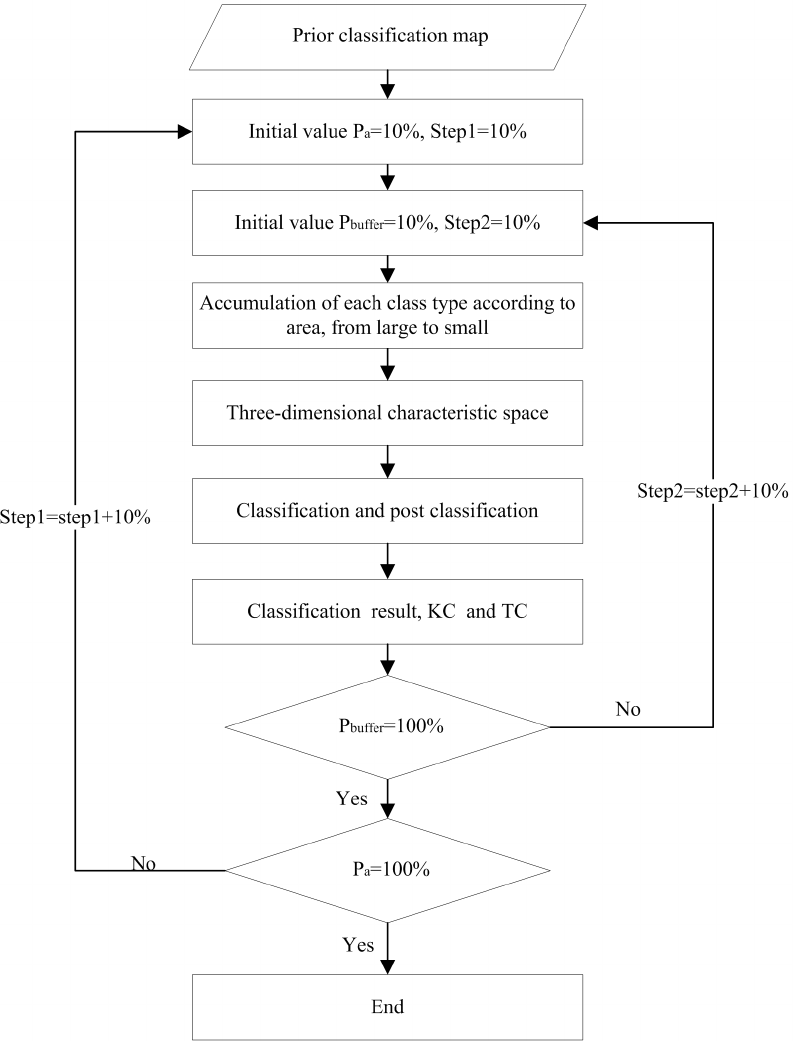
Figure 2. Flowchart of the iterated procedure used to determine the key parameters ( P a and P buffer ) (KC: Kappa Coefficient; TC: Time-Consuming).